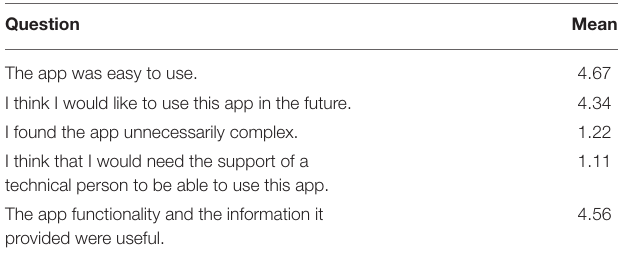
TABLE 1 | Mean responses to questions where 1 = strongly disagree, 5 = strongly agree. Question